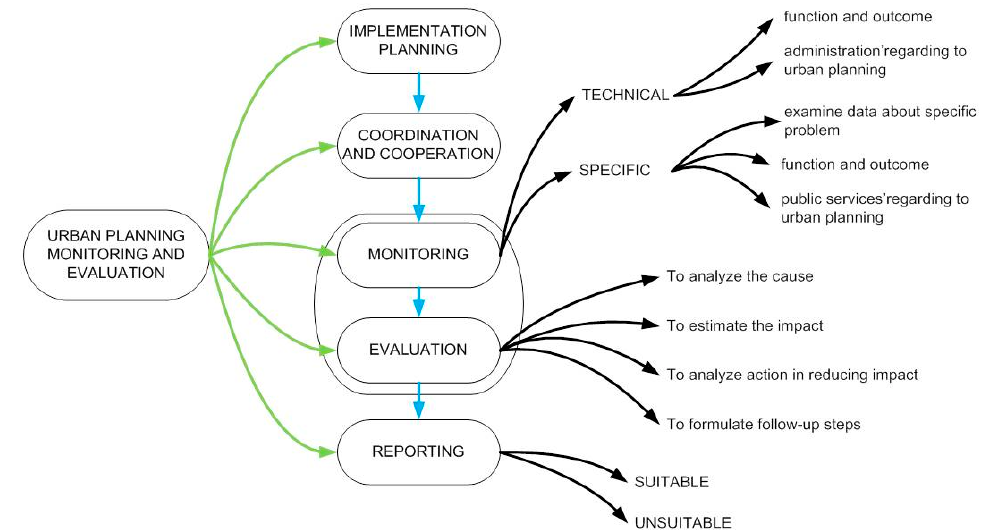
Figure 5. The workflow of Urban Planning Monitoring Process in Indonesia according to Indonesian Government Regulation No. 15 Year 2010 [64].